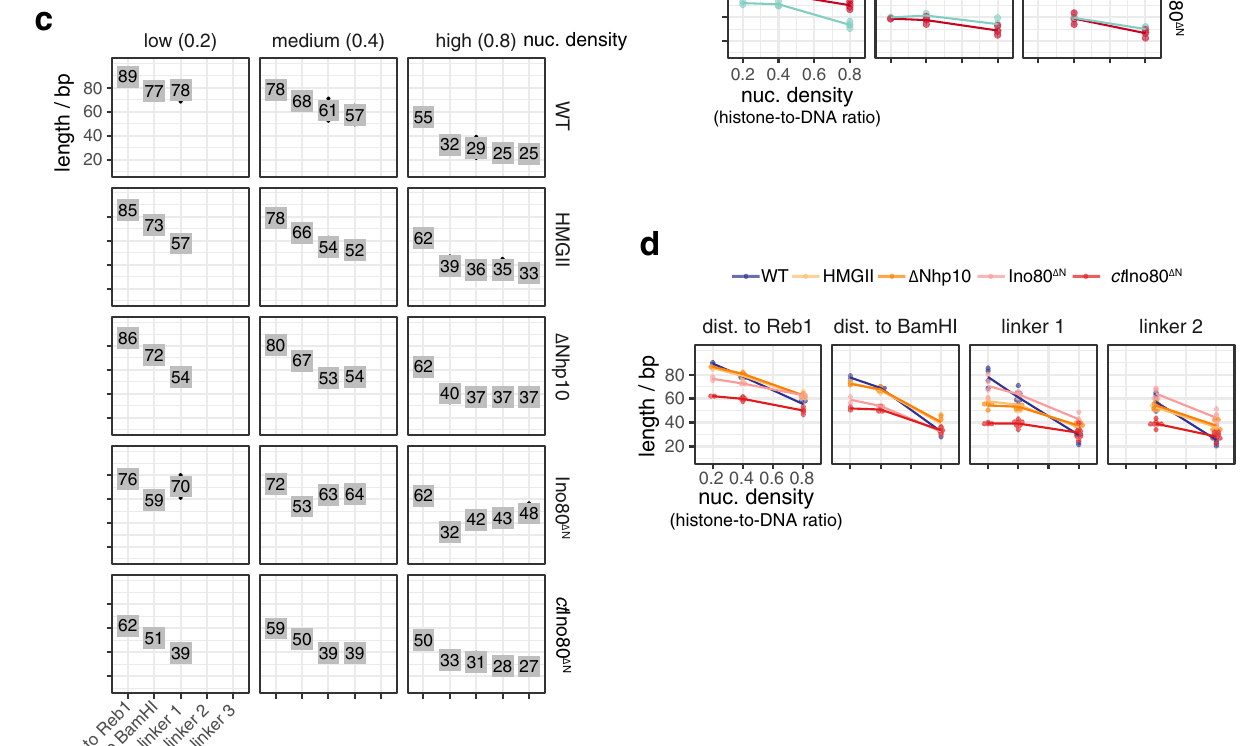
Fig. 6 Mutations in the INO80 Nhp10 module affect the generation of array features. a – d As Fig. 5a – d, respectively, but for the indicated WT and mutant INO80 complexes. Composite plots of individual replicates in Supplementary Fig. 5a. Data for WT INO80 are the same as in Fig. 5.